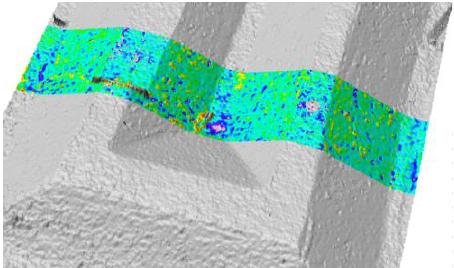
Figure 5. Segment 1 (view from